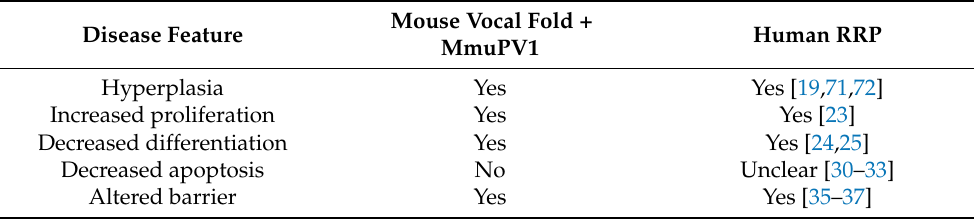
Table 2. Epithelial similarities and differences between vocal fold disease in NSG mice infected with MmuPV1 and RRP.